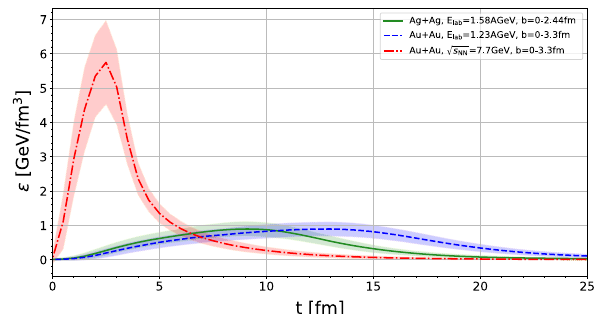
Fig. 9 Time evolution of the energy density in the center of the system for central Ag+Ag at E lab = 1.58 AGeV, Au+Au at E lab = 1.23 AGeV √ s NN = 7.7 GeV collisions. The colored error bands and Au+Au at correspond to the standard deviations